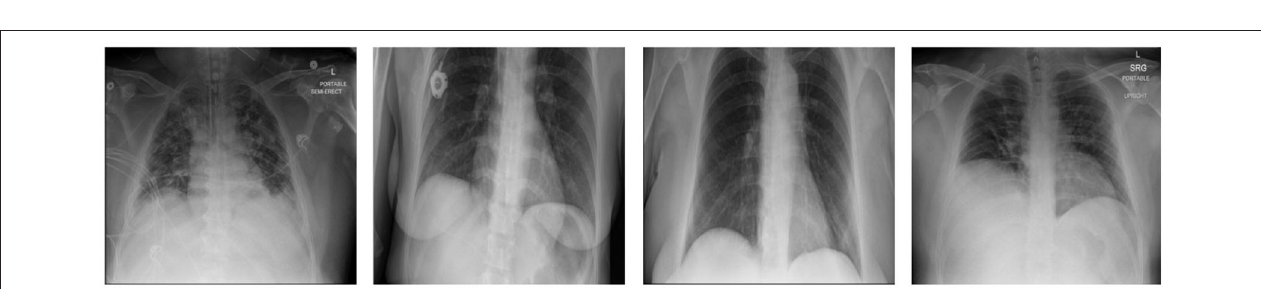
FIGURE 2 | Example chest X-ray images from the benchmark